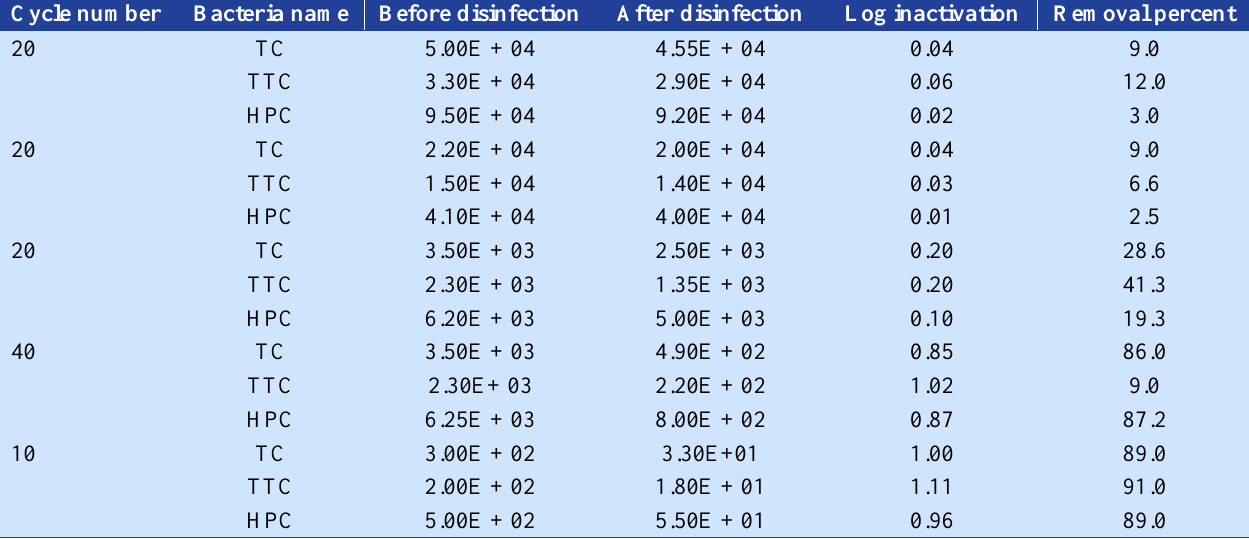
Table 1. Hydropad steam KLEAR S38 device results after each cycle Cycle